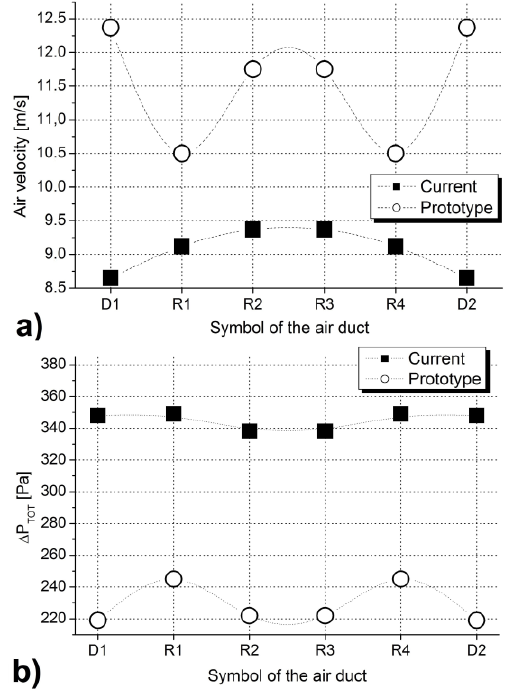
Fig. 2. Example of comparison of air flow characteristics (subsequent air outlets) obtained in case of the reference air manifold and the prototype with the bent main body: a) velocity, b) total pressure drop relative to